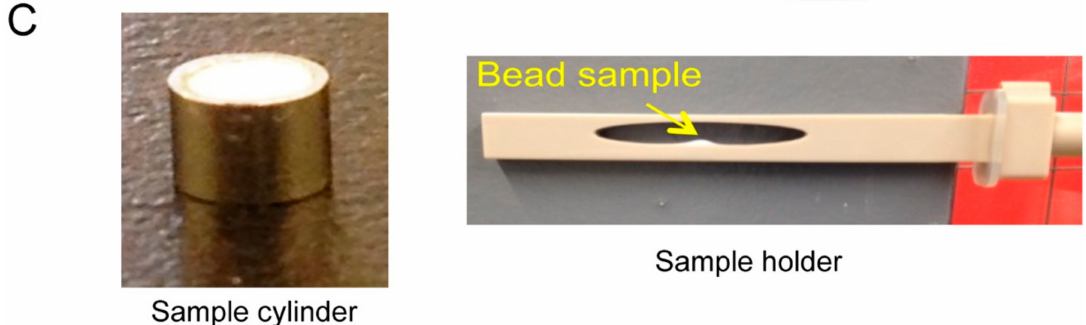
Figure 2. Graphical representation of the working principle of ( A ) surface dissolution imager (SDI) technology, ( B ) the instrument, and ( C ) sample preparation